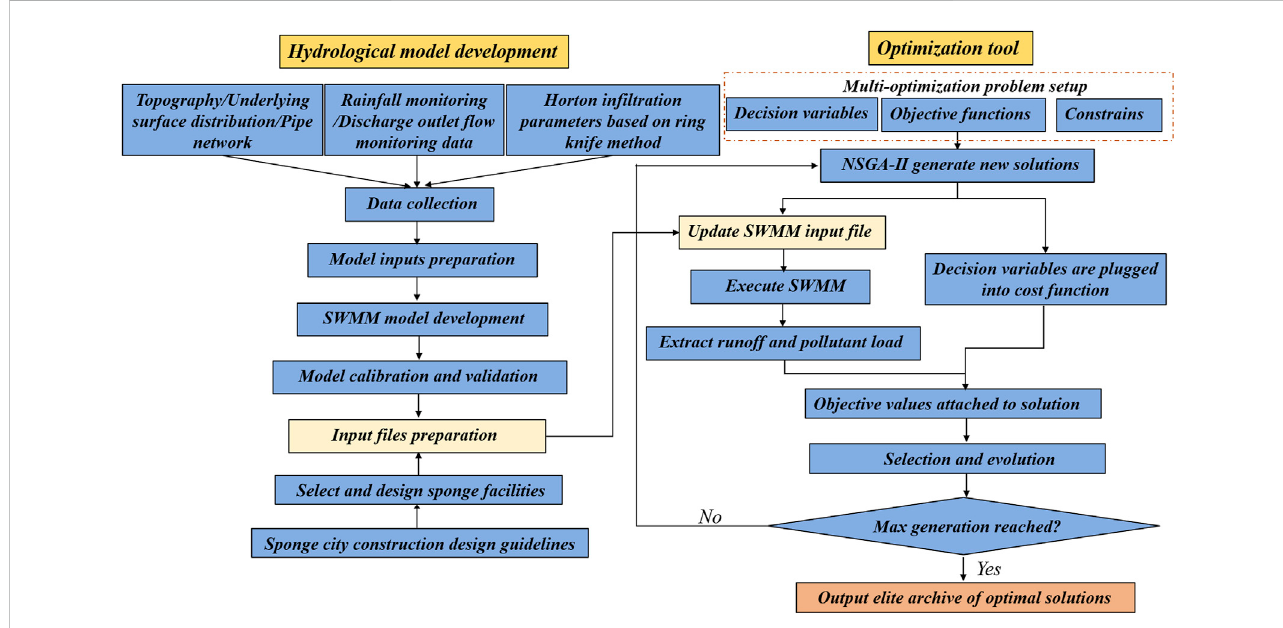
FIGURE 1 Flowchart of simulation-optimization model integration.